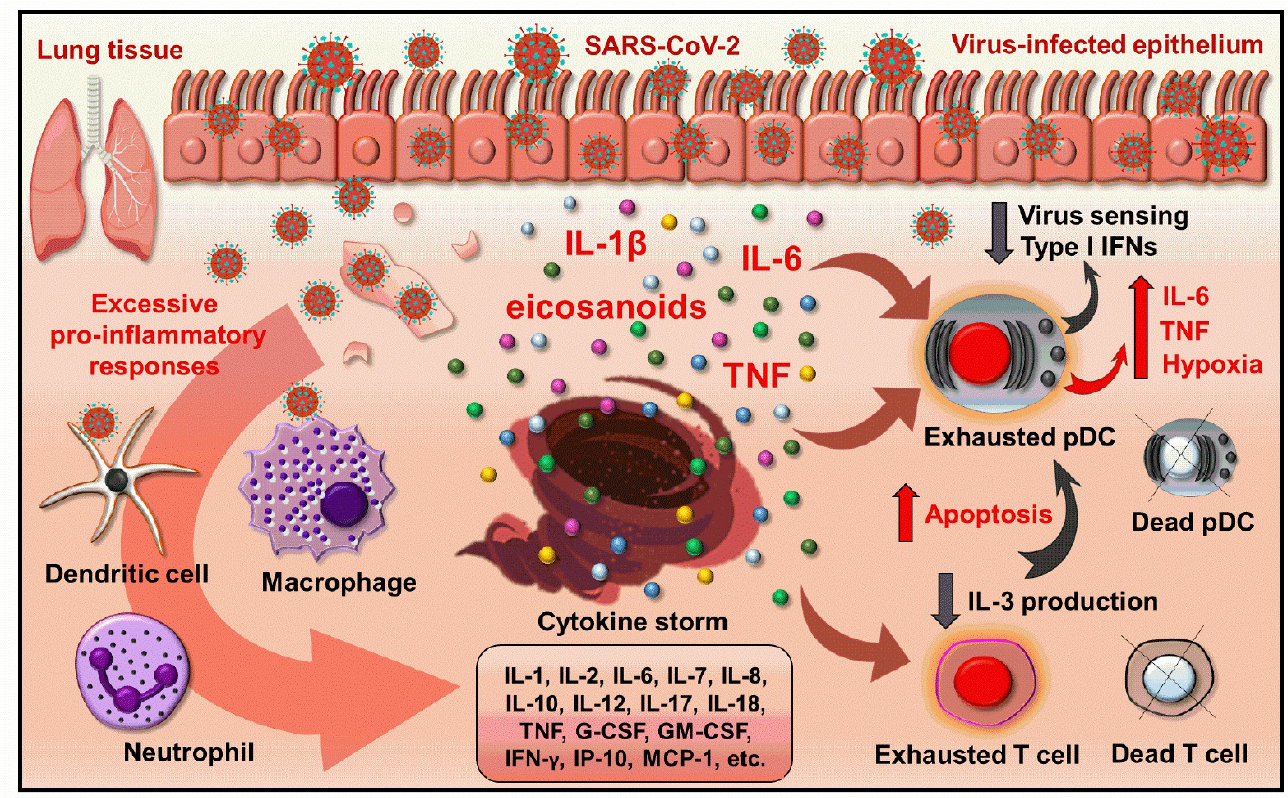
Figure 2. The inflammatory microenvironment in severe COVID-19 leads to the exhaustion and decreased antiviral potential of pDCs. The overactivation of immune cells in severe COVID-19 leads to an excessive production of pro-inflammatory cytokines and eventually cascades into a cytokine storm. This inflammatory environment drives pDC exhaustion that is characterized by high hypoxia and functional abnormalities of pDCs. However, the inflammatory environment has an inhibitory effect on the virus sensing ability and type I IFN production of pDCs, and their pro-inflammatory cytokine production comes to the fore that can further fuel the detrimental inflammatory circuit. The excessive inflammatory milieu also causes T cell exhaustion and leads to increased T cell death. Consequently, the levels of T cell-derived IL-3, which is an essential survival factor for pDCs, also drop and that leads to pDCs apoptosis. Thus, severe COVID-19 is associated with a reduced number of pDCs. G-CSF: granulocyte colony stimulating factor; GM-CSF: granulocyte-macrophage colony stimulating factor; IFN: interferon; IP: interferon gamma-induced protein, MCP: monocyte chemoattractant protein; pDC: plasmacytoid dendritic cell; TNF: tumor necrosis factor.